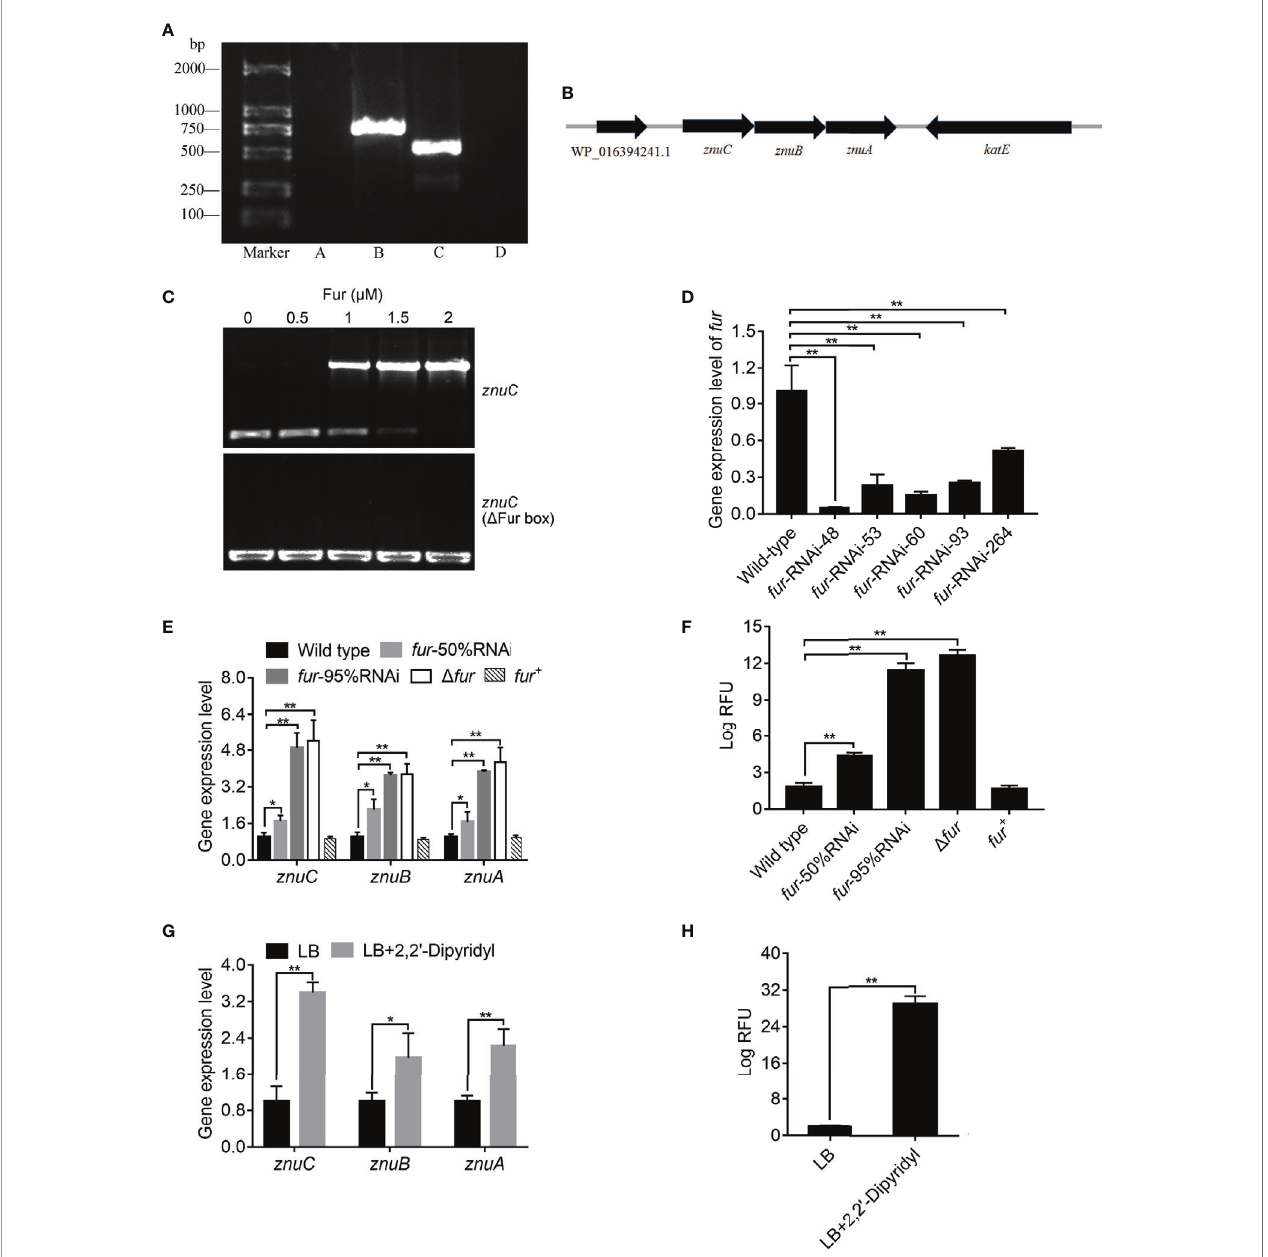
FIGURE 6 | ZnuCBA is negatively regulated by Fur. (A) In order to validate whether znuA , znuB and znuC were transcribed into a single mRNA molecule, reverse transcription PCR (RT-PCR) was carried out to assess RNA isolated from Pseudomonas plecoglossicida using four pairs of primers. Pair A was designed to amplify the region between WP_016394241.1 and znuC , pair B between znuC and znuB , pair C between znuB and znuA , and pair D between znuA and katE . Primer pairs A and D produced no bands, while primer pairs B and C produced bands of correct sizes. (B) Genetic organization of the znuCBA operon. (C) To validate the binding of Fur on the znuC promoter, the electrophoretic mobility shift assay (EMSA) was carried out. 6-carboxy fl uorescein-labeled DNA fragment from the promoter region of znuC (upper panel) or DNA fragment with the same boundaries but with Fur box removal (lower panel) was added to the reaction mixture containing different concentrations of the Fur protein. (D) In order to assess the function of Fur, fi ve fur -RNAi strains were constructed, and the silencing ef fi ciencies were validated by quantitative real time PCR (qRT-PCR). (E) To validate whether the Fur in P. plecoglossicida is important for the regulation of znuCBA , qRT-PCR was carried out in wild type, fur -50%RNAi, fur -95%RNAi, D fur and fur + strains. (F) For further validating znuCBA downregulation via Fur, a znuCBA -reporter gene fusion controlled by the putative Fur promoter (nt -900 to +150) was constructed. Expression was assessed by measuring fl uorescence with fur knocked down or knocked out. (G) To validate the effect of Iron (Fe) limitation on znuCBA expression, expression of znuCBA in wild type were compared in LB and Fe-limiting condition with 2 ’ ,2-Dipyridyl. (H) For further validating znuCBA upregulation under Fe limitation, transcription levels of the znuC -GFP reporter gene fusion in P. plecoglossicida under Fe limiting conditions was detected. Values are mean ± SD (n = 3, * P < 0.05, ** P <